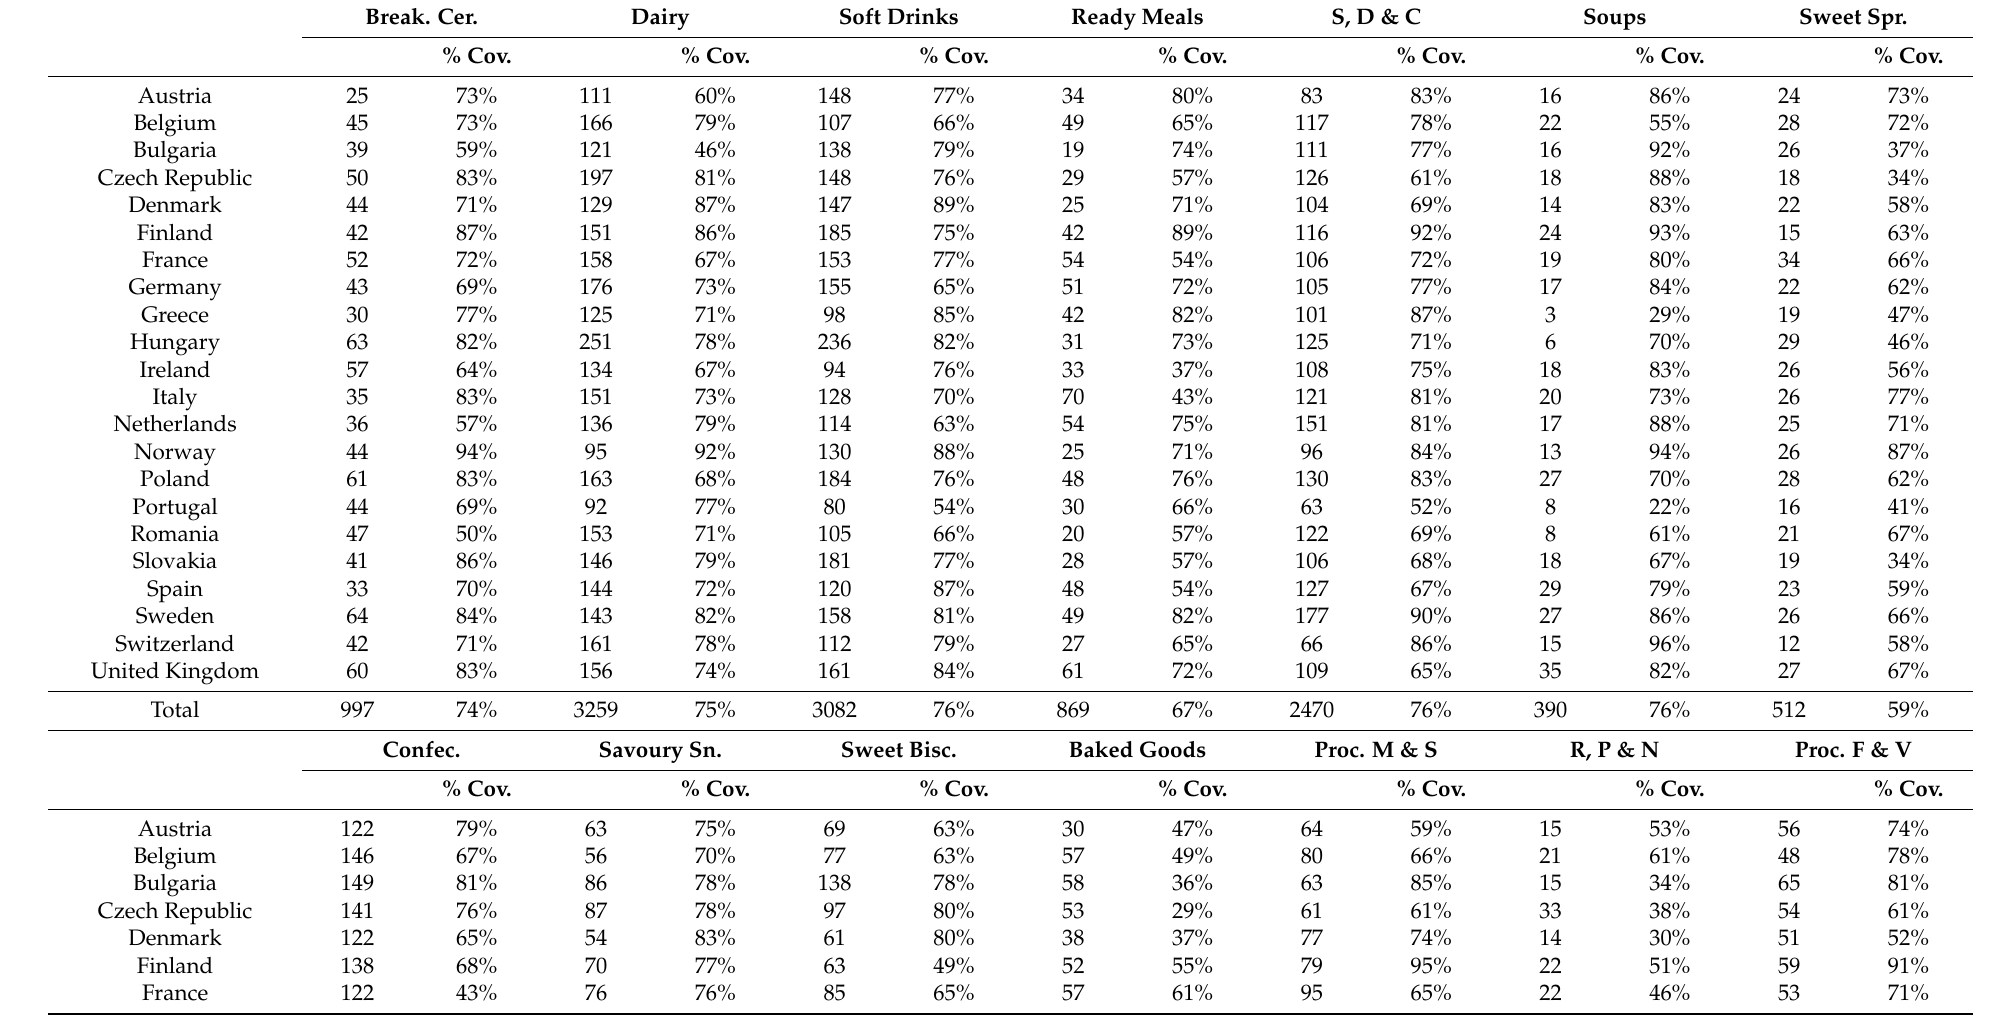
Table A2. Number of products extracted from the Euromonitor database and their respective market coverage (in %) in 2015, per category and country. Break. Cer. Dairy Soft Drinks Ready Meals S, D & C Soups Sweet Spr. % Cov. %